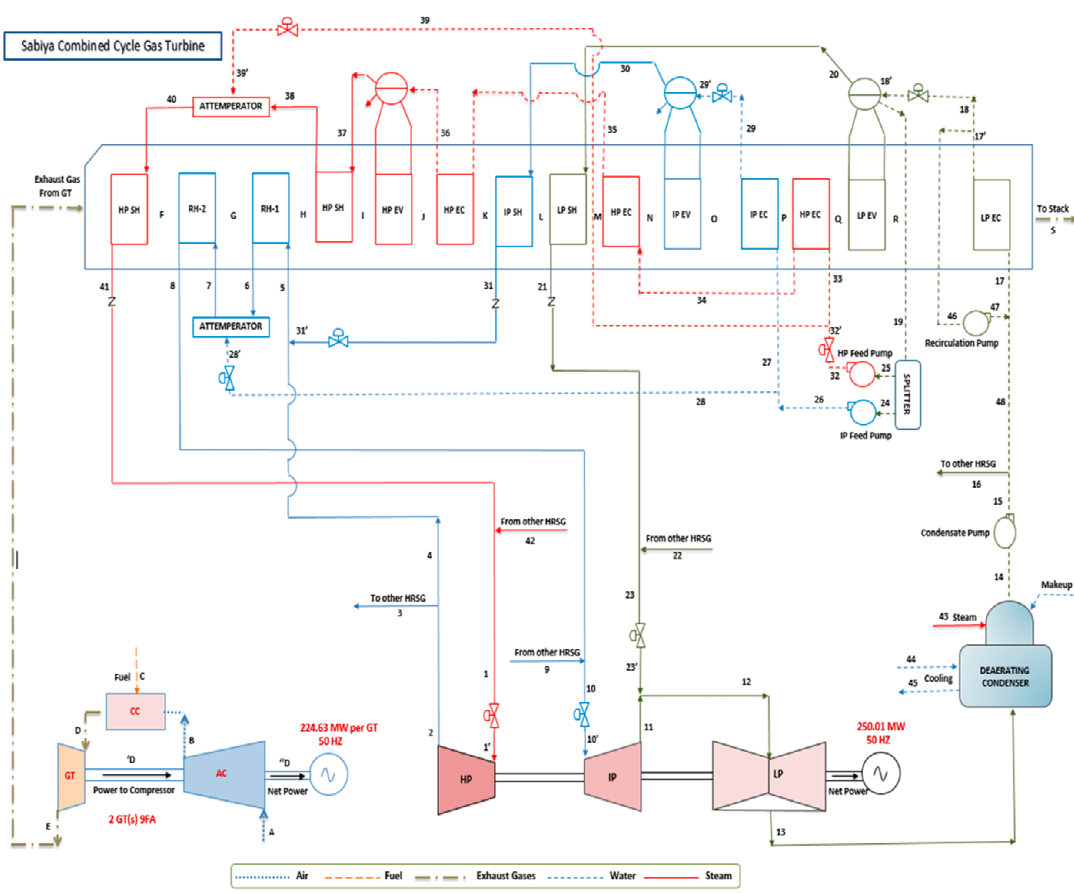
Figure 1. Schematic diagram for a Single Block of Sabiya Combined Cycle Power Plant [14].